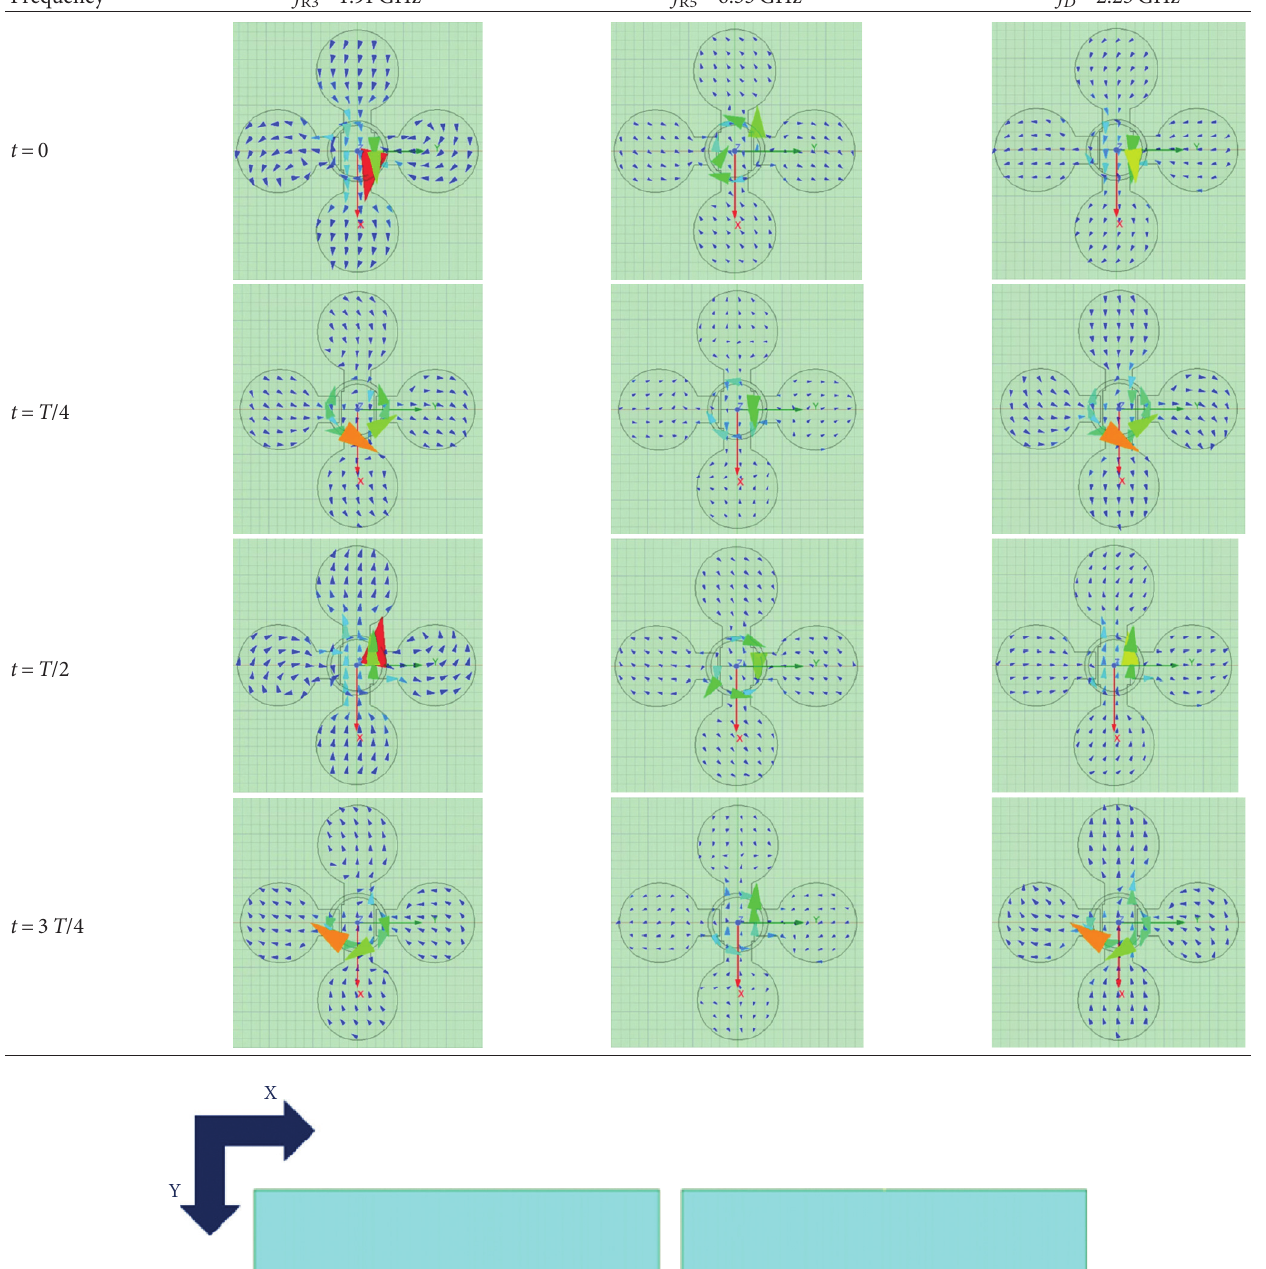
� 1.91GHz and f � 6.53GHz, as R 3 R 5